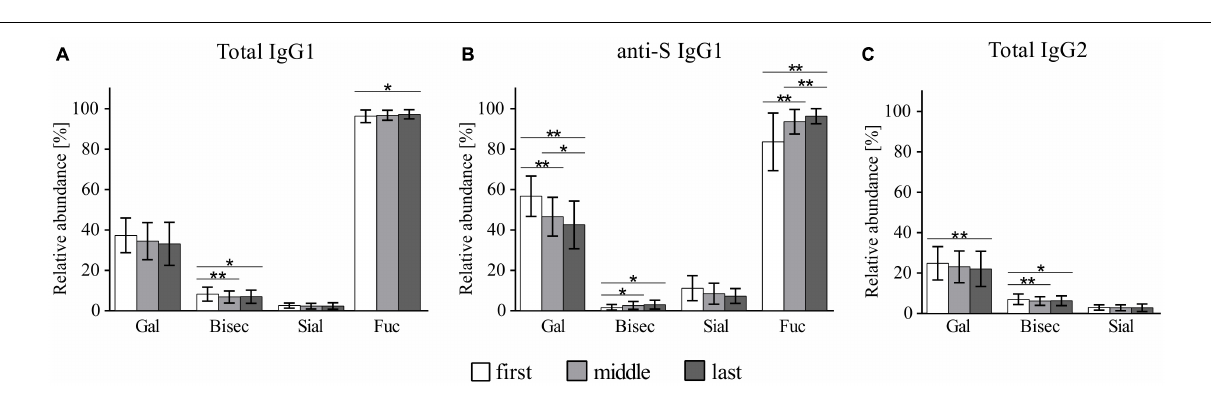
Frontiers in Microbiology |